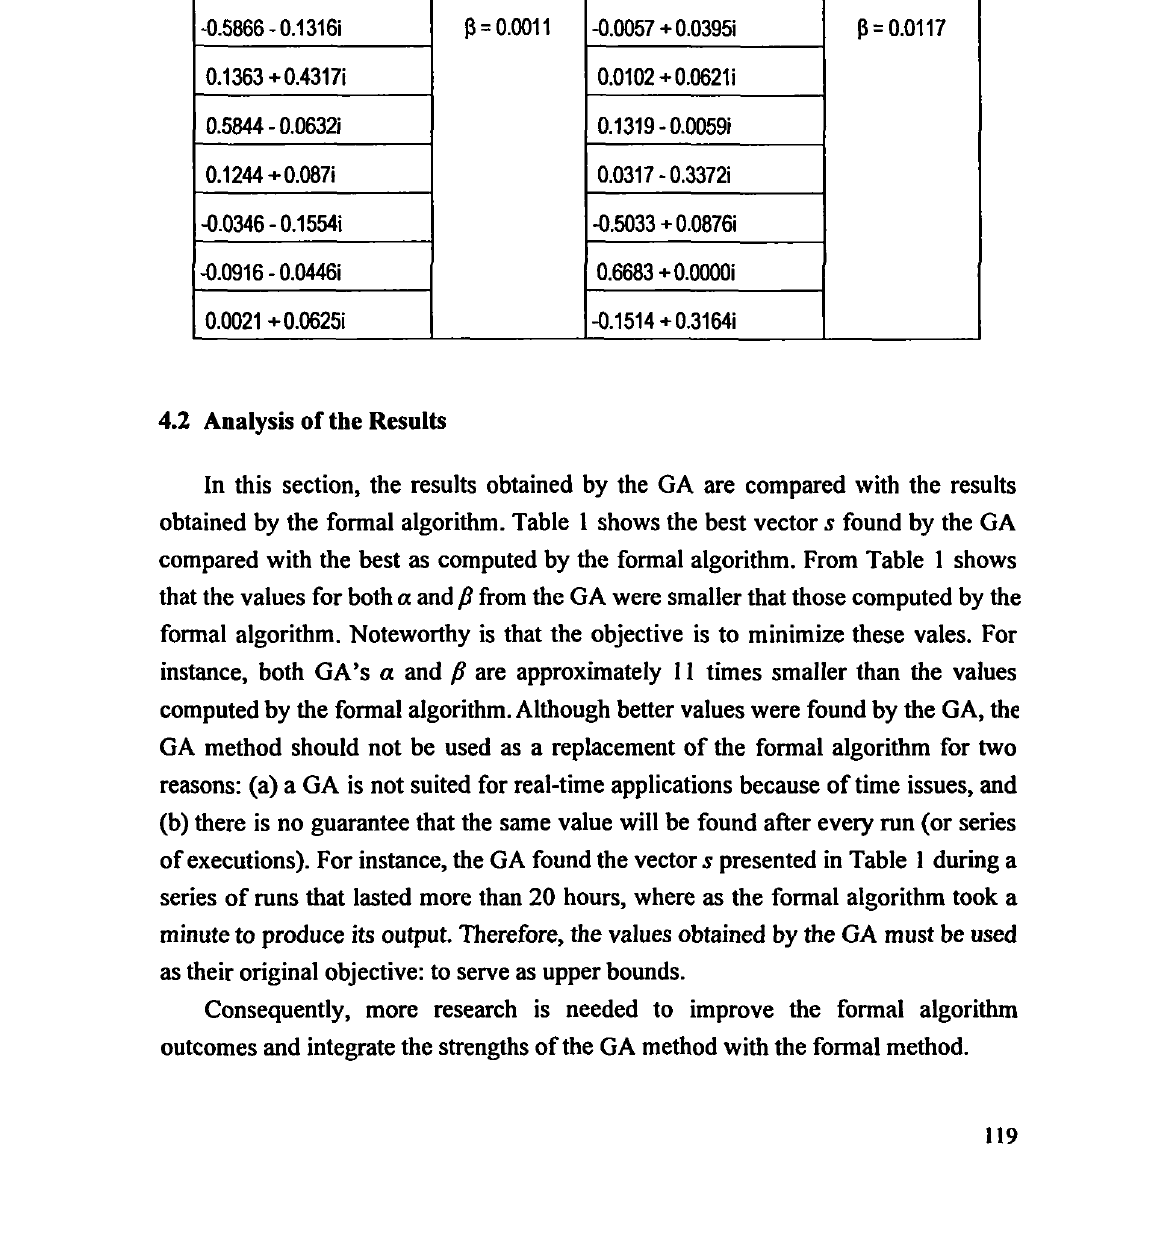
GA And Formal Algorithm